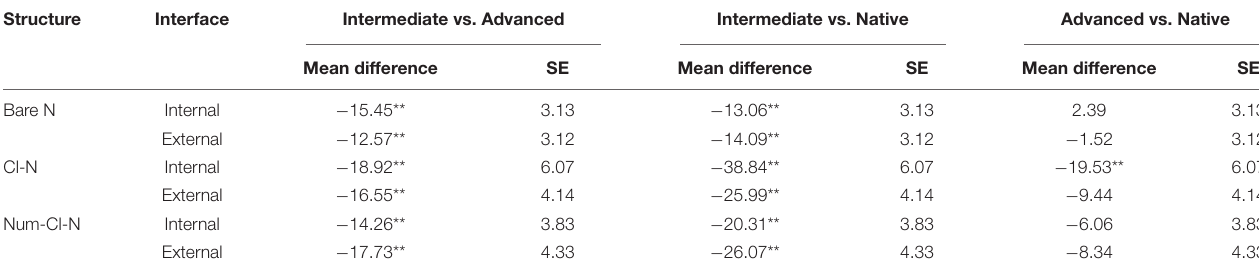
TABLE 4 | Pairwise comparison results for the three-way interaction in accuracy rate. Structure